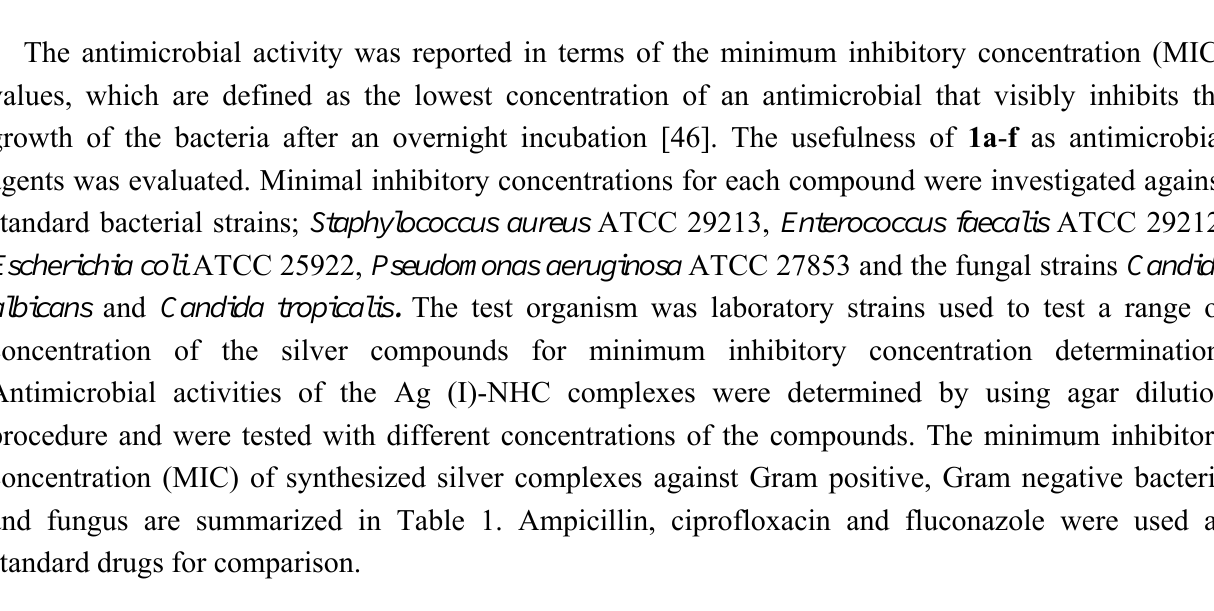
Table 1. Minimum inhibitory concentration ( μ g/mL) of silver NHC complexes tested against bacterial and